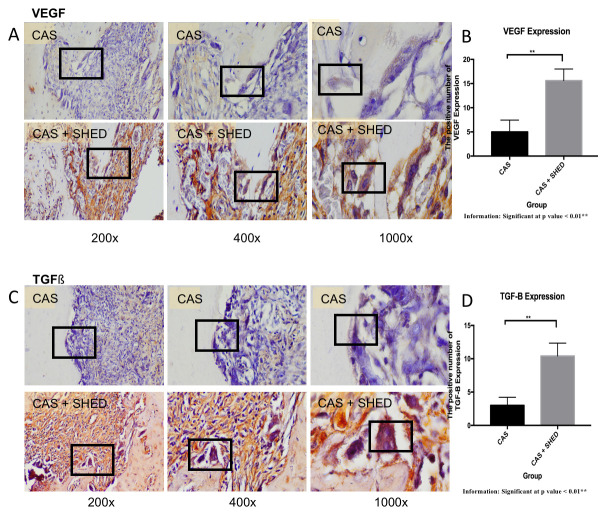
Histological sections of the Wistar rats’ (
R. Novergicus) afflicted periodontal tissues.Immunohistochemistry with antibody monoclonal (AbMo) and DAB were performed to examine the (
A) VEGF and (
B) TGF-β expressions. The positive cells were stained brown (black box) with 200x, 400x, and 1000x magnification using the light microscope. The number of osteoblasts expressing (
C) VEGF and (
D) TGF- β in the alveolar bone of the rats.